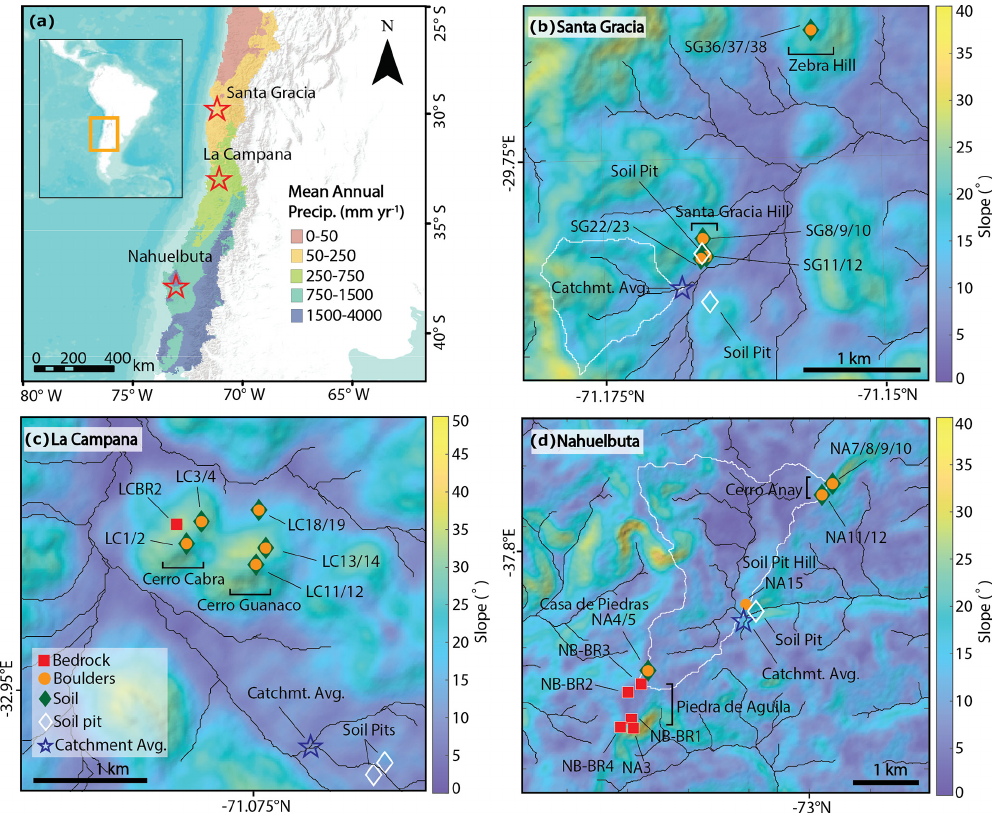
Figure 1. Field site locations and features. (a) Map of mean annual precipitation in central Chile, with field sites marked by red stars. Precipitation data from the CR2MET dataset, by the Center for Climate and Resilience Research (CR 2 ) (Boisier et al., 2018), provide an average for the time period 1979–2019. World Terrain Base map sources are Esri, USGS, and NOAA. B-D: slope and hillshade maps from 12.5m ALOS PALSAR digital elevation models of (b) Santa Gracia (SG; Alaska Satellite Facility Distributed Active Archive Center, 2011b), (c) La Campana (LC; Alaska Satellite Facility Distributed Active Archive Center, 2019), and (d) Nahuelbuta (NA; Alaska Satellite Facility Distributed Active Archive Center, 2011a). Sample locations and sample names are shown, with symbol shape and color indicating the sample type (see legend in c ). White outlines delineate the catchments from which the catchment average sample (star) was taken (the catchment from La Campana does not fit within the bounds of the map and is therefore not shown). Black lines indicate streams. Soil pit sample data are from Schaller et al. (2018), and catchment average sample data are from van Dongen et al.